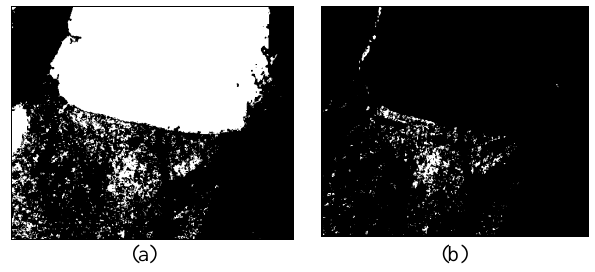
Figure 11. The elevation mask processing: (a) Elevation mask and (b) Image result after the elevation mask processing The ASTER GDEM was used to create the elevation mask.